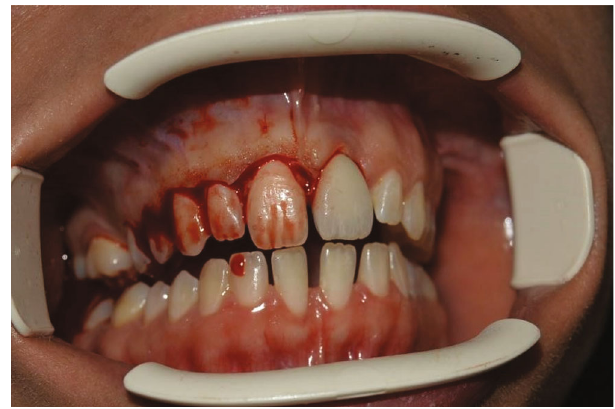
Figure 7: 3 months later, the tissues were properly stabilized and the de fi nitive crown was inserted, completing the